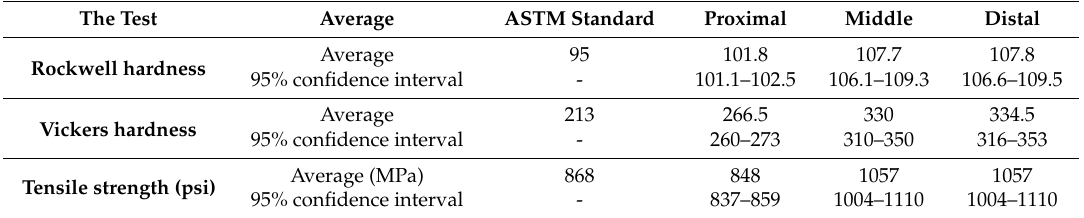
Table 2. Rockwell hardness B-scale test, Vickers hardness, and tensile strength results.